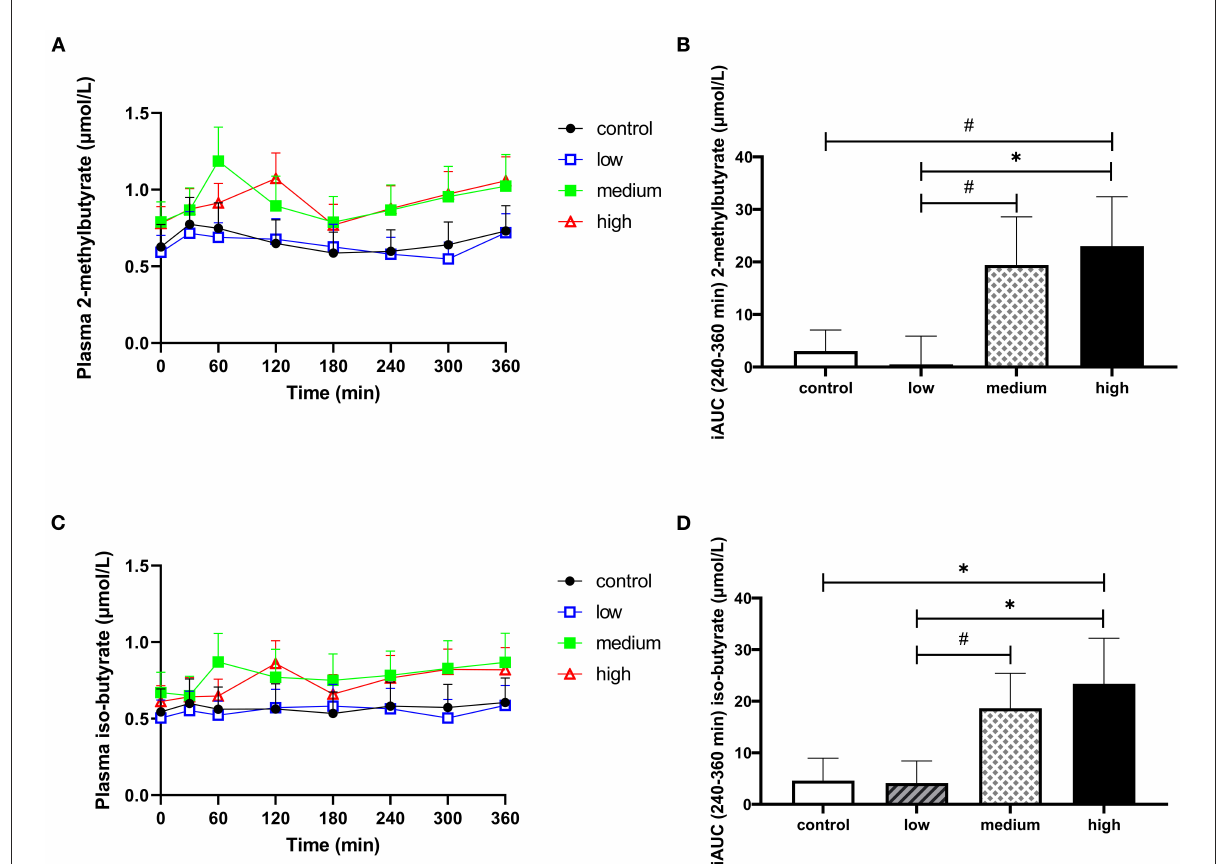
FIGURE4 The effect of butyrate and hexanoate-enriched triglycerides on the circulating branched chain fatty acids. (A, B) 2-methylbutyrate and (C,D) iso-butyrate. (A) Postprandial plasma 2-methylbutyrate concentrations (t0–t360min) after butyrate and hexanoate-enriched triglyceride ingestion. (B) iAUC for postprandial (t240–360min) plasma 2-methylbutyrate following butyrate and hexanoate-enriched triglyceride ingestion. Overall treatment effect (Type III Test of Fixed Effects) for postprandial (t240–360min) plasma 2-methylbutyrate p = 0.073. (C) Postprandial plasma iso-butyrate concentrations (t0–t360min) after butyrate and hexanoate-enriched triglyceride ingestion. (D) iAUC for postprandial (t240–360min) plasma iso-butyrate following butyrate and hexanoate-enriched triglyceride ingestion. Overall treatment effect (Type III Test of Fixed Effects) for postprandial (t240–360min) plasma iso-butyrate p = 0.043. Values are presented as means ± SEMs ( n = 12). Differences in postprandial iAUC between the four doses interventions (control, low, medium, high) were analyzed by a linear mixed model for repeated measures and the indicated p-values represent post-hoc testing. Statistical significance indicated with an asterisk (*) if p < 0.05 and (#) if P < 0.10, indicating a trend. iAUC, incremental area under the curve.